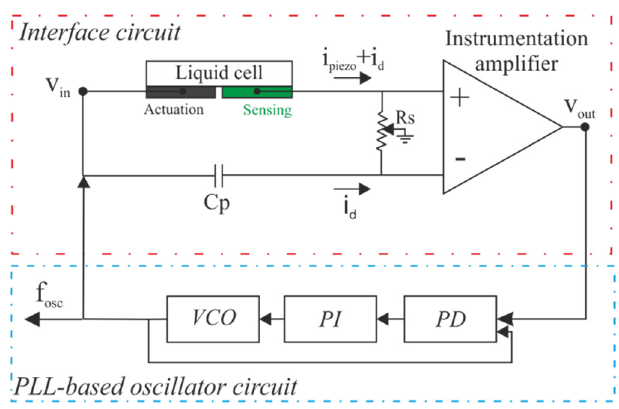
Figure 11. Schematics of the PLL-based oscillator and the interface circuit.